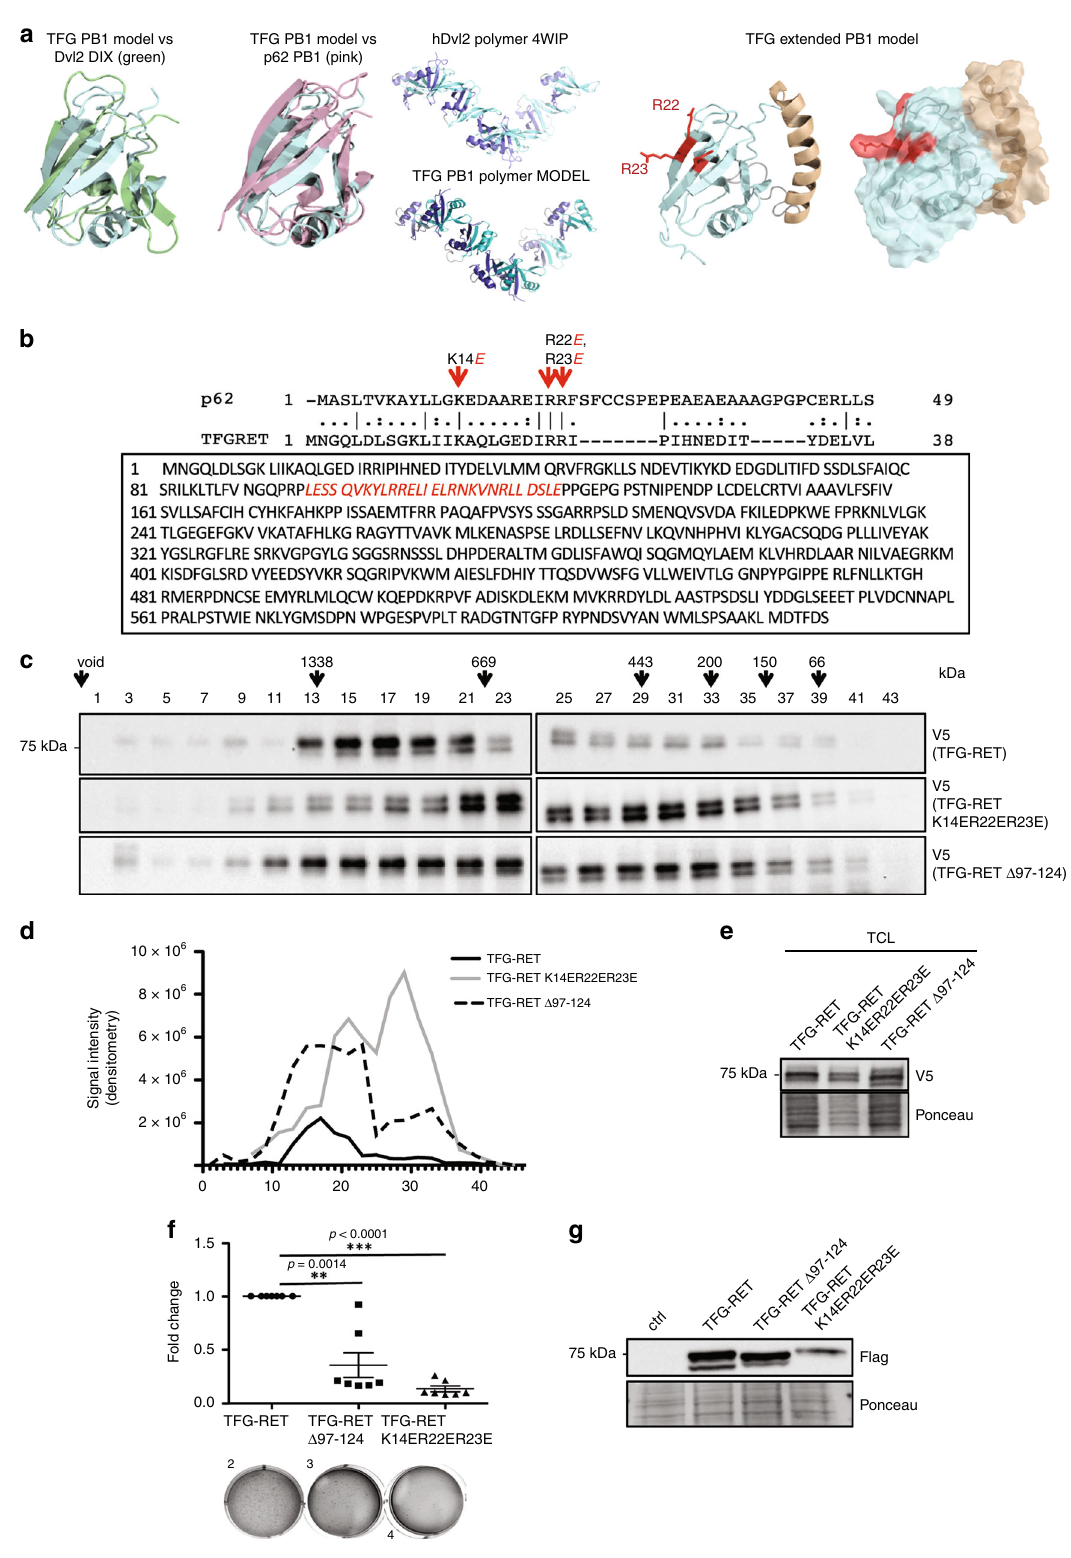
University Medical Center Mainz in accordance with the regulations of the tissue bank. Isolation of protein, DNA and RNA from patient tissue . The tumor tissue was incubated in collagenase-D solution (1 mg/mL) (11088866001, Roche) at 37°C for 2 h and then transferred to a 6-well plate and cut into smaller pieces with a